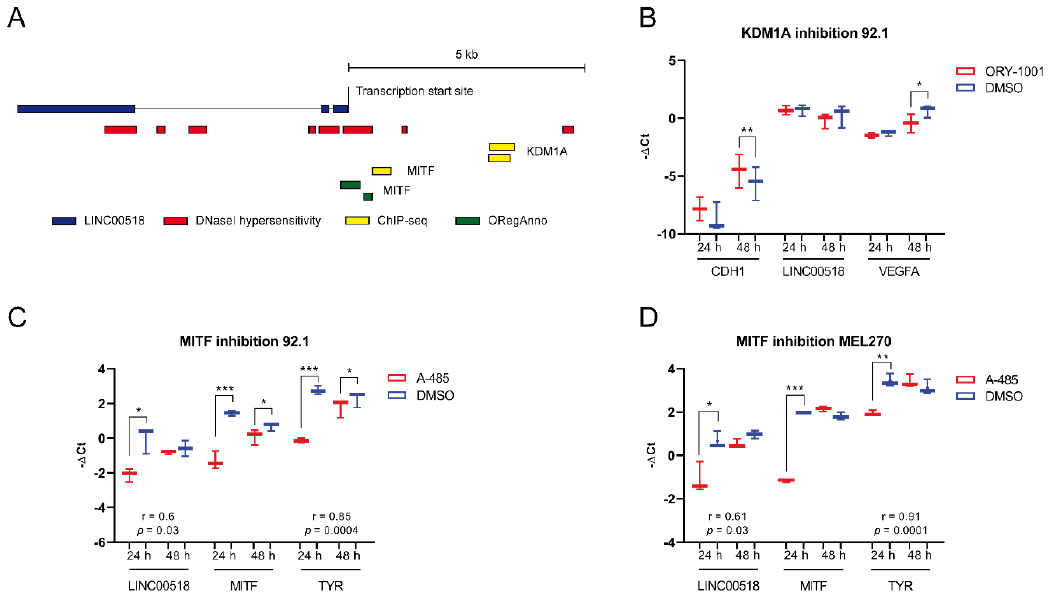
Figure 11. Identification of TFs potentially regulating LINC00518 expression. ( A ) Experimentally validated transcription factor binding sites (TFBSs) upstream of the transcription start site of LINC00518 locus. ( B ) Expression analysis after KDM1A inhibition achieved by ORY-1001. ( C , D ) Expression analysis after MITF inhibition through A-485 treatment in 92.1 and MEL270 cells, respectively. Correlation of expression with MITF is shown. Each experiment was performed in three in